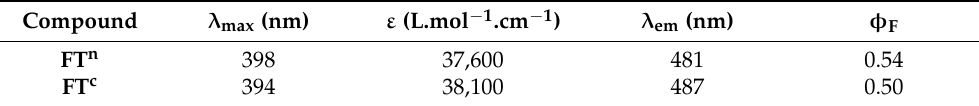
Figure 2. Normalized UV-Vis absorption spectra (plain curves) and emission spectra (dashed curves) of FT c and FT n in DMSO. Table 2. Characteristic values of optical properties of the fluorescent building blocks in DMSO.